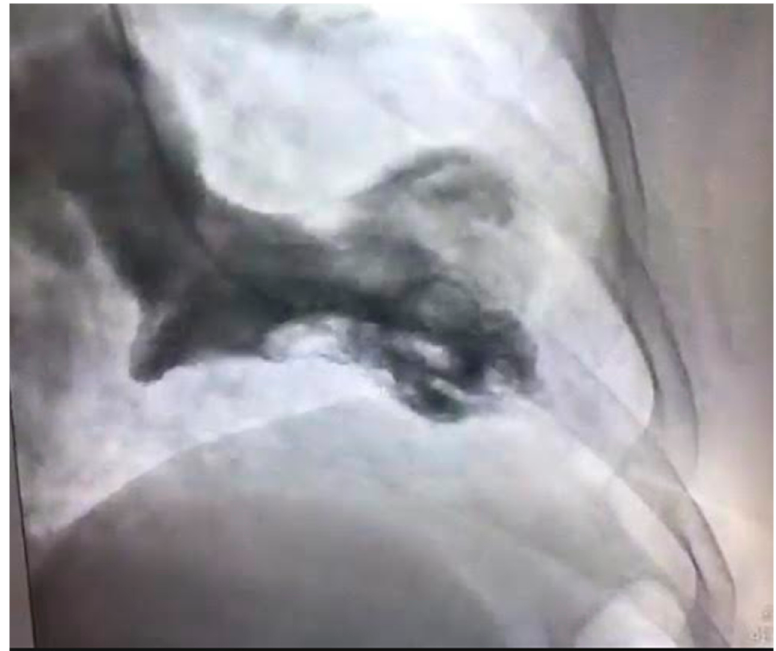
Figure 3. Left ventricular angiogram in a 56-year-old patient with Takotsubo